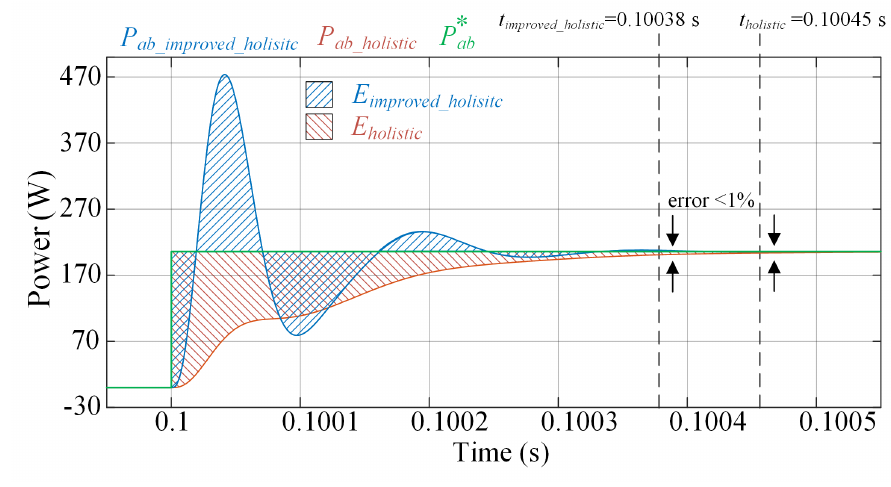
Figure 7. Voltage step response in ISM going from 0 W to 205.7 W.